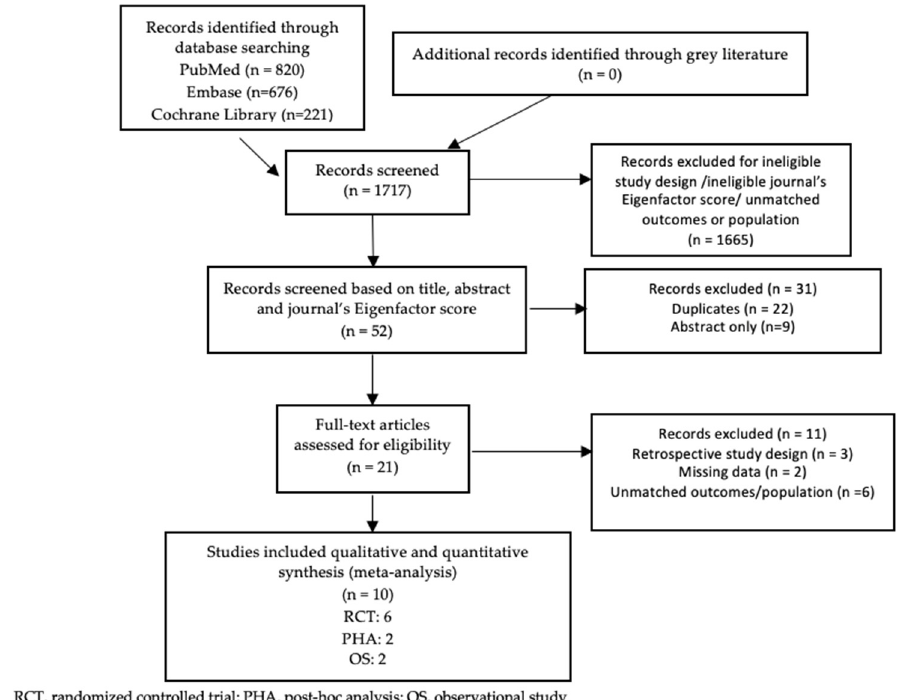
Figure 1. The PRISMA flow diagram for the study